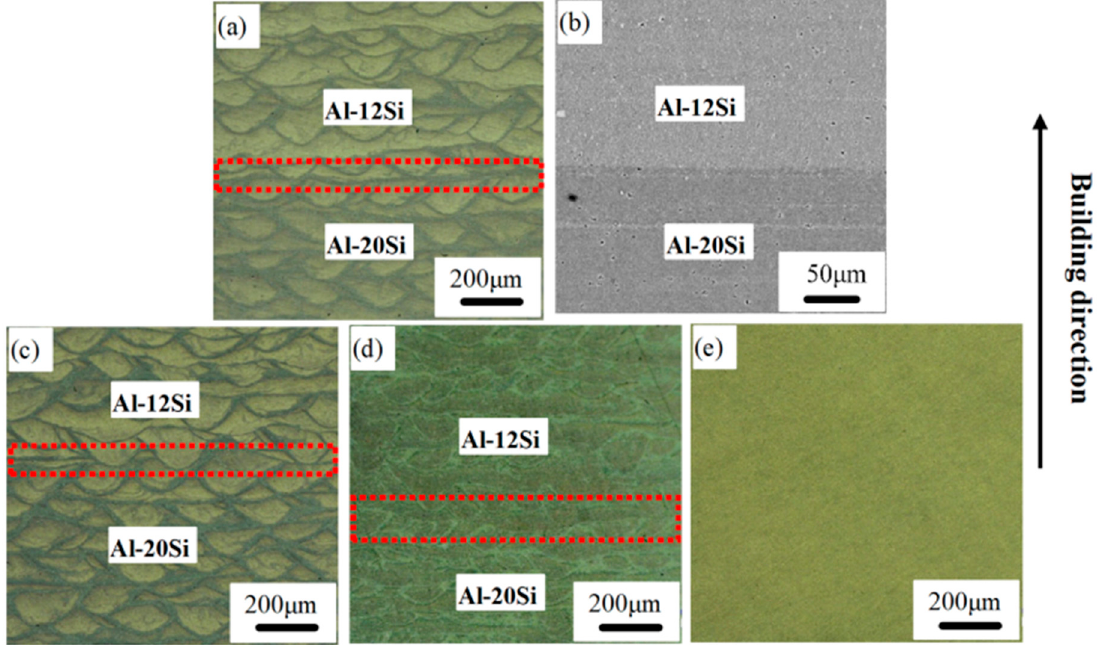
Figure 3. Microstructure of Al–Si bi-materials fabricated by selective laser melting (SLM) and heat treatment: ( a , b ) SLM; ( c ) SLM + 473 K/6 h; ( d ) SLM + 573 K/6 h; ( e ) SLM + 673 K/6 h.